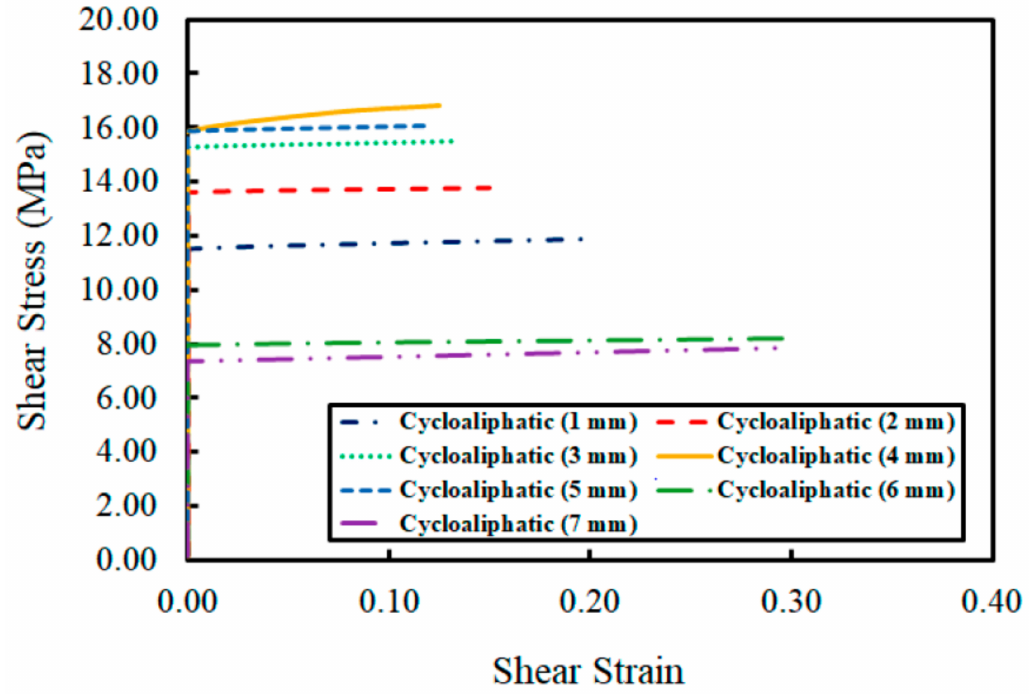
Figure 7. Impact of the ratio between the resin and the hardening agent on the mechanical strength of the epoxy